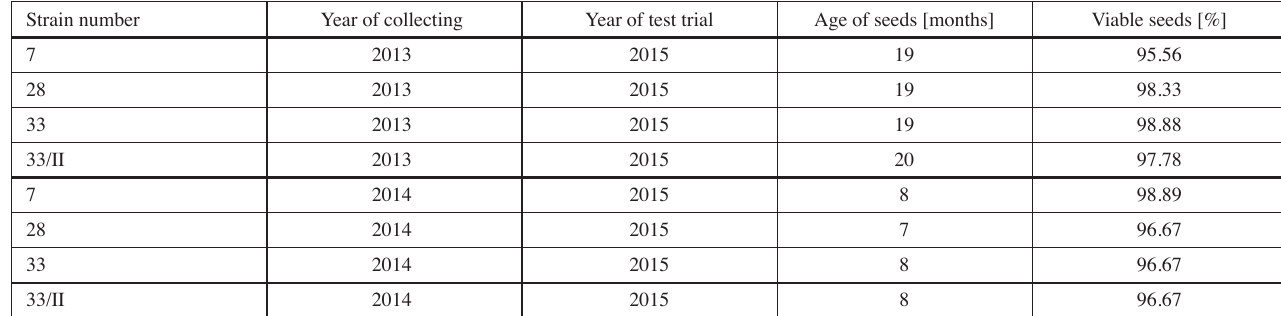
Tab. 4: Viability and vigour of lemon balm seeds collected in 2013 and 2014 by tetrazolinum test